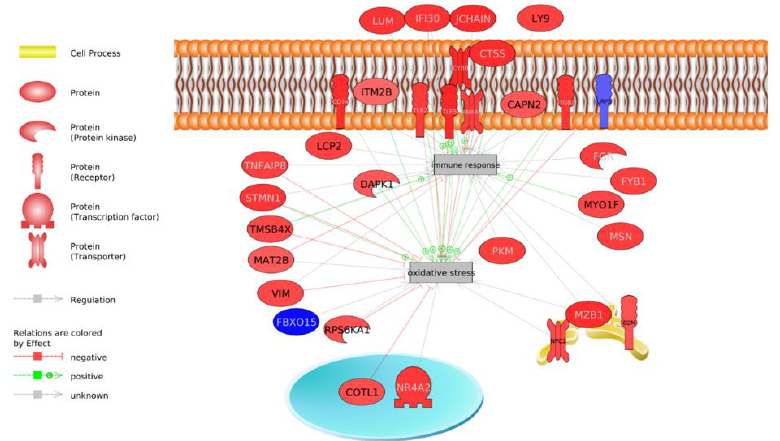
Figure 4. DEGs involved in the immune response and oxidative stress with an effect known using Pathway Studio software. Highlighted in red are genes over-expressed in the LRFI group and in blue are under-expressed genes in the LRFI group. Green arrows indicate a known positive regulation effect, red arrows indicate a known negative regulation effect and gray arrows indicate an unknown regulation effect.